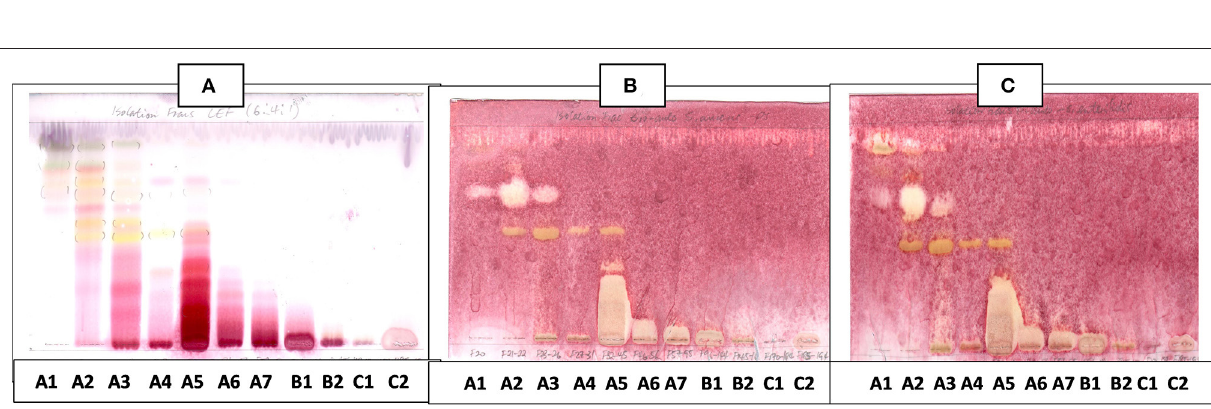
Frontiers in Veterinary Science |